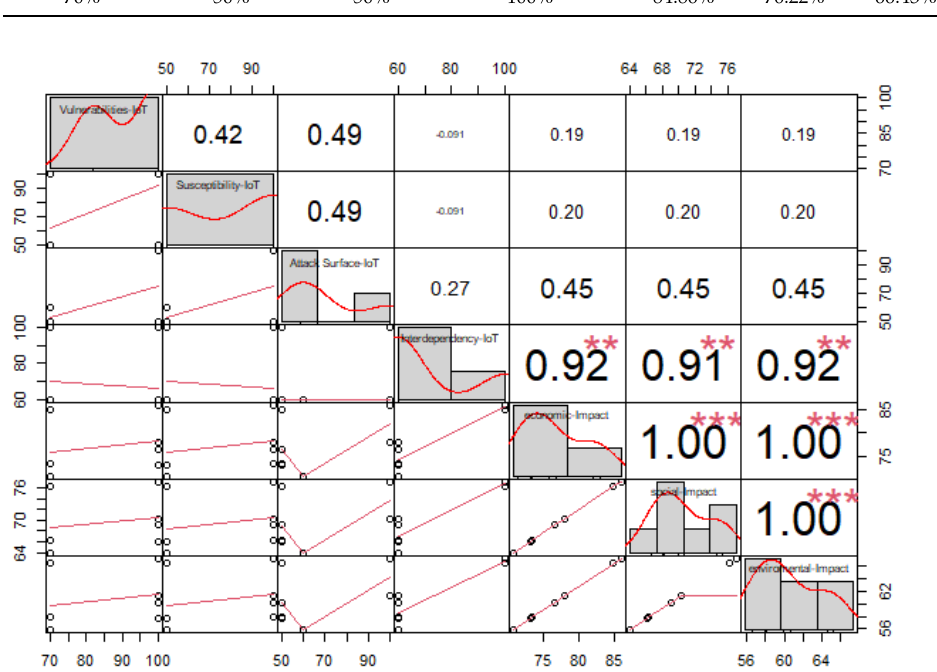
Figure 23. Correlation between input and output variables of IoT security risk. The symbols ** represents a high relationship (upper 80%) between variables. The symbols *** represents a very high relationship (100%) between variables.